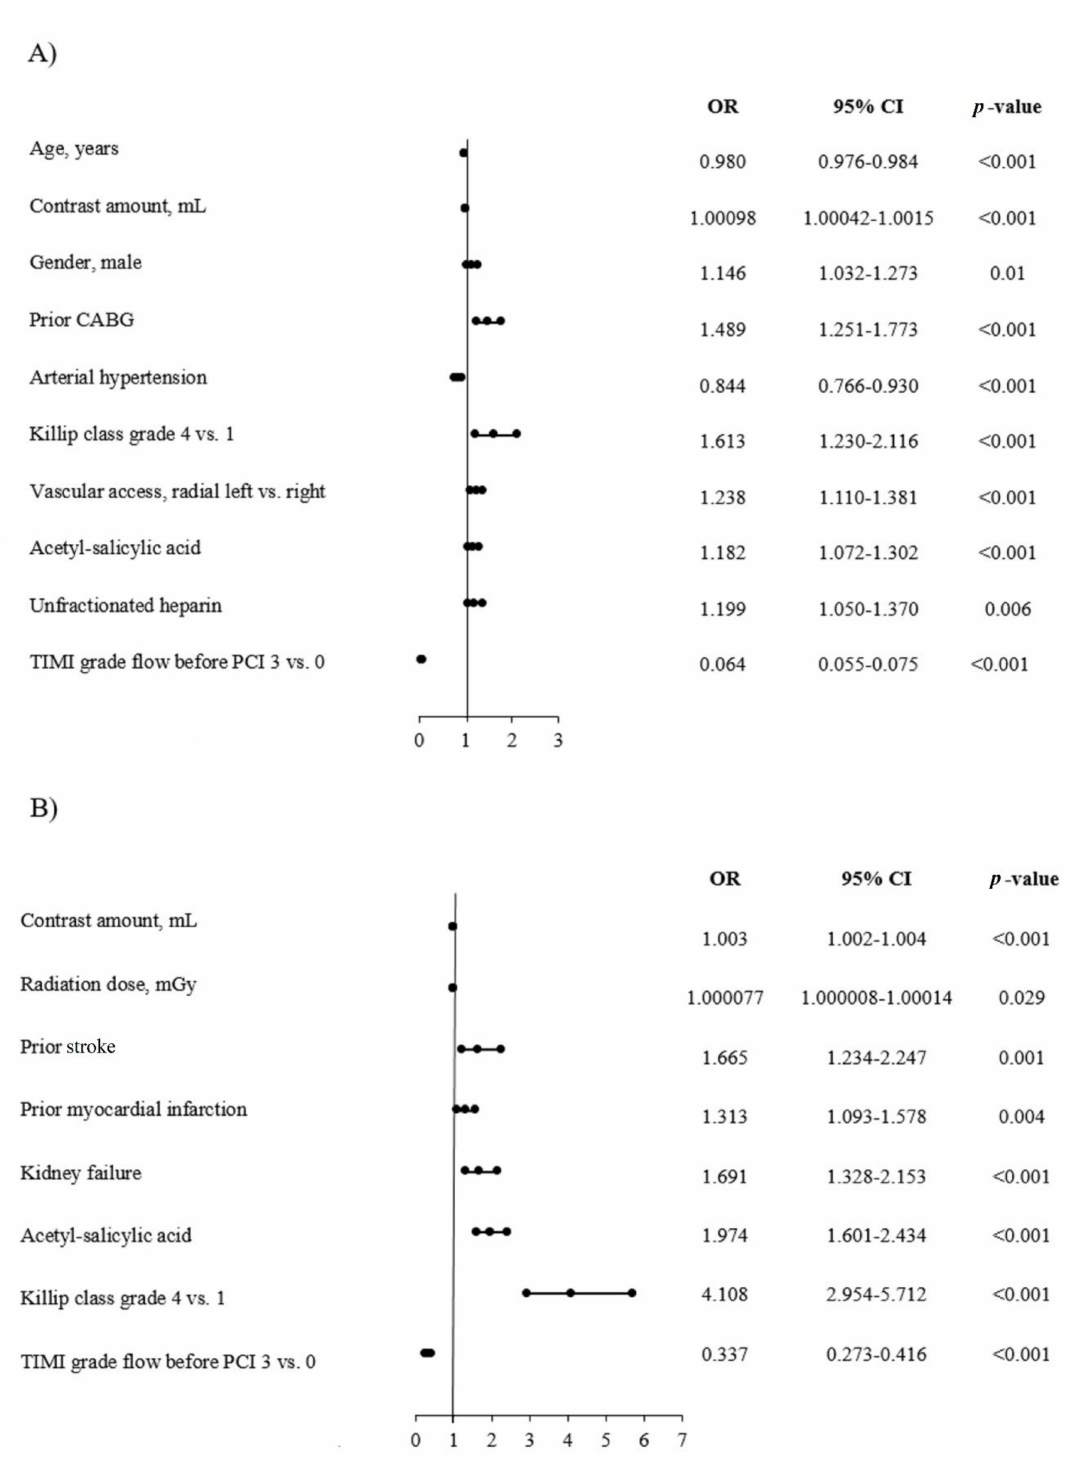
Figure 4. Predictors of TA and no-reflow phenomenon in the NSTEMI subgroup. ( A ) Thrombus aspiration. ( B )